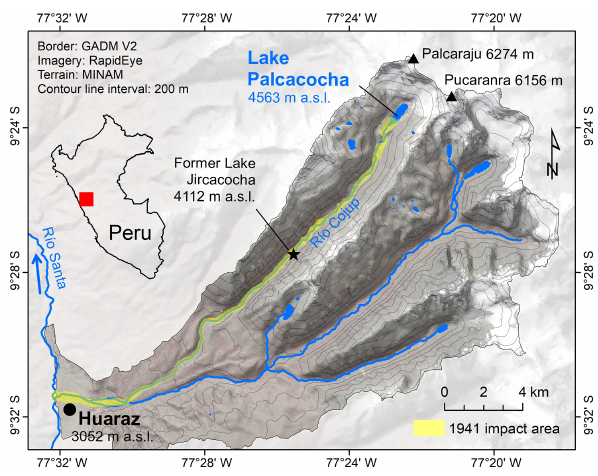
Figure 1. Location and main geographic features of the Quilcay catchment with Lake Palcacocha and the former Lake Jircacocha. Table 1. Characteristics of Lake Palcacocha (1941 and 2016) and Lake Jircacocha (1941), and changes due to the 1941 GLOF. Topo- graphic reconstruction according to field observations and historic photographs. Additional information from Vilímek et al. (2005) and ANA